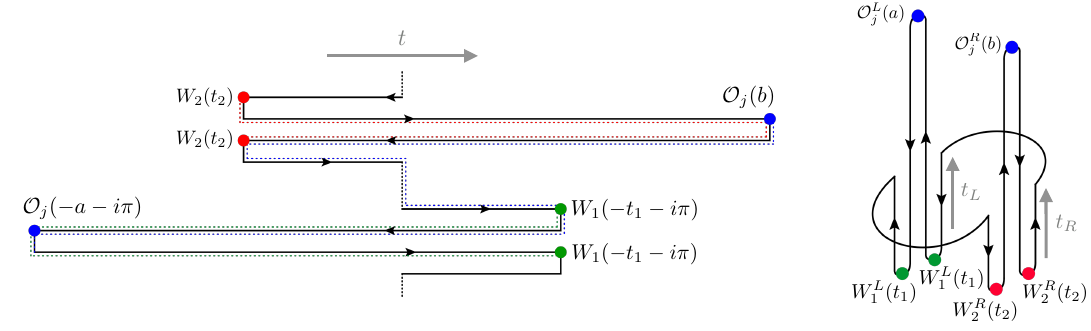
Figure 2 . Illustration of the ‘irreducibly’ out-of-time-order configuration (2.3). We show the complex time contours where the three perturbations have support, as well as the left-right con- figuration, which is inspired by the bulk picture. The complex contour time coordinate is t − t L − iπ for right and left boundary times,